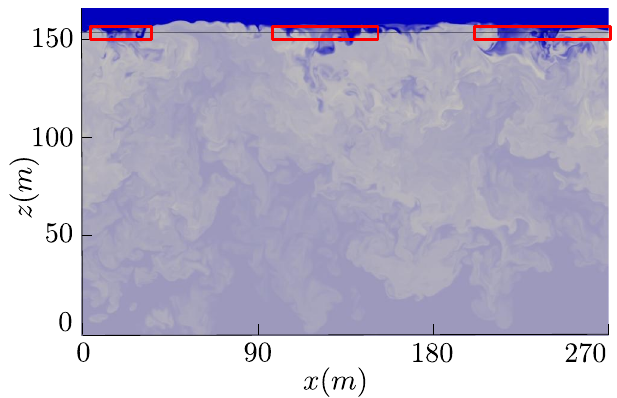
Figure 11. Results from direct numerical simulation of the turbu- lence in the cloud top entrainment zone: vertical cross section of the calculated cloud liquid water with the color scale extending from 0.0gkg − 1 (blue) to 0.325gkg − 1 (white). The black line indicates the simulated aircraft trajectory through the scenario and the red rectangles mark the “cloud holes”, i.e., air parcels mostly of cloud free air.